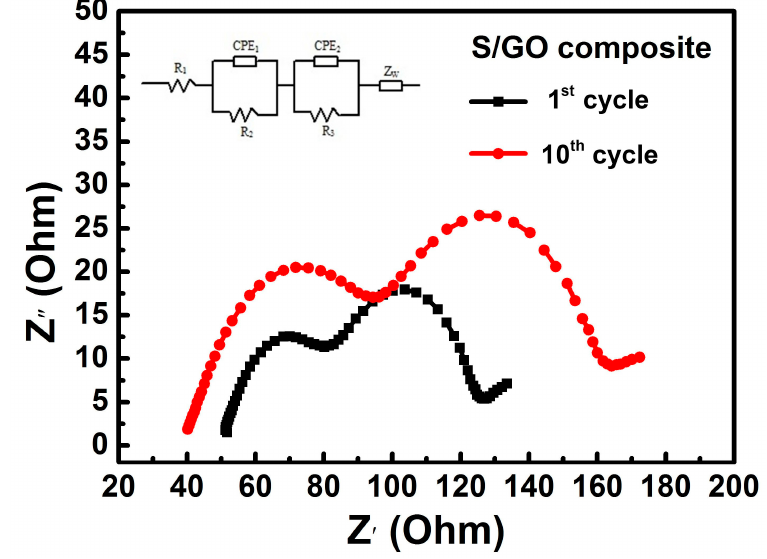
Figure 11. Electrochemical impedance spectroscopy (EIS) impedance of a lithium sulfur battery with the S/GO composite (inset shows the obtained equivalent circuit).